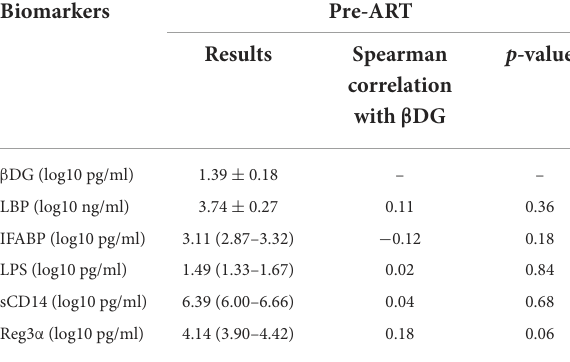
TABLE 2 Association of microbial translocation and gut damage markers with β -D-glucan ( β DG) levels pre- antiretroviral therapy (ART).